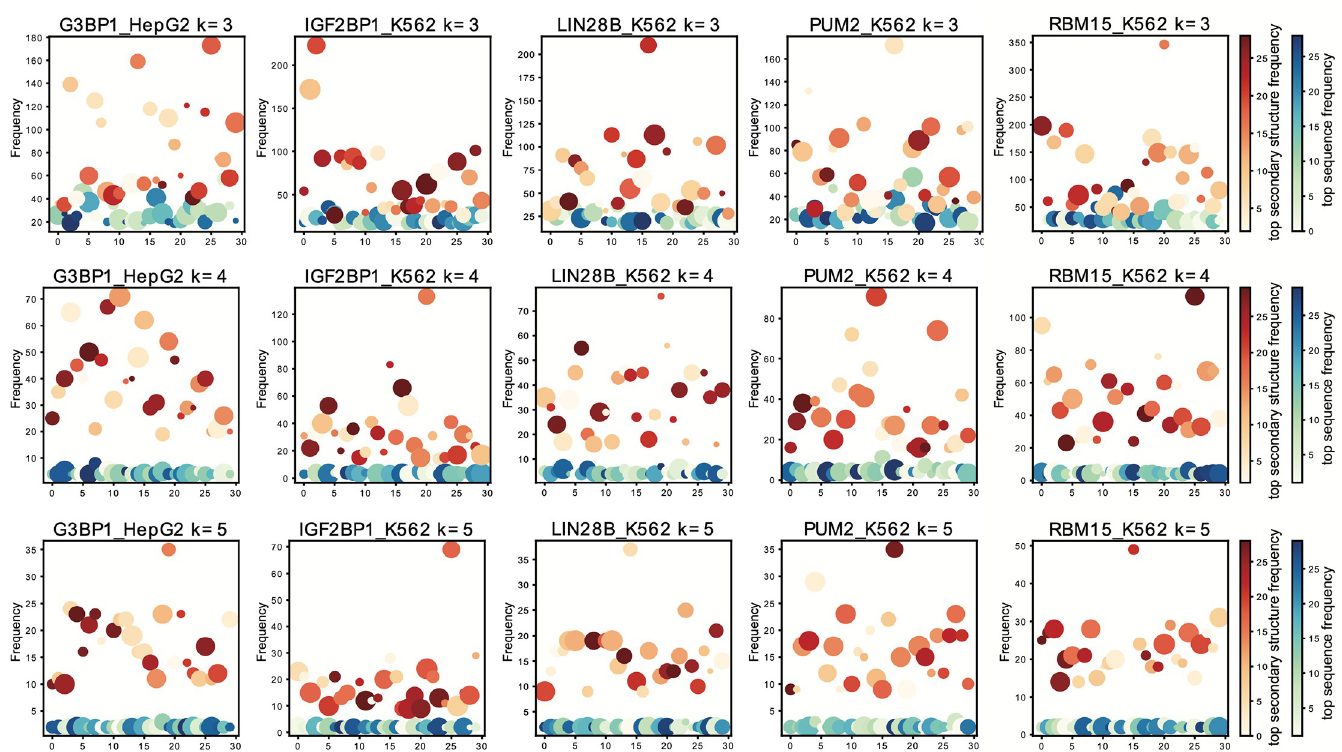
Fig 4. Distribution of the frequency of top sequence- and structure- instances in final EKS pool for 5 RBPs.